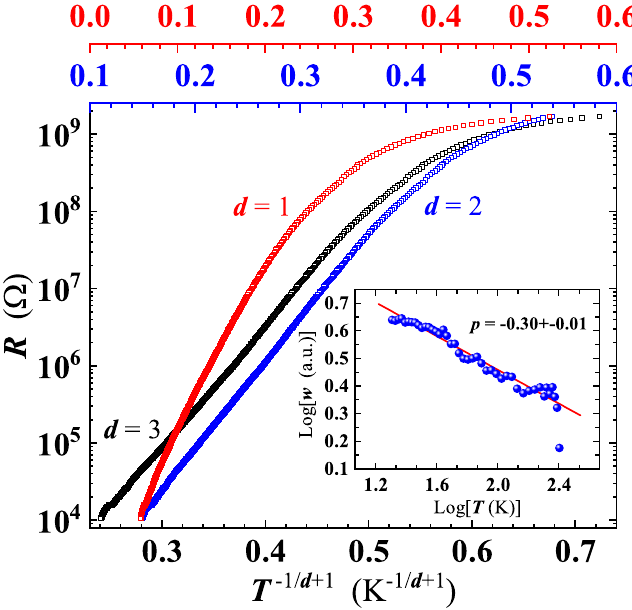
Figure 10. Analysis of the variable range hopping conduction mechanism in the GS, plotting the sample resistance as a function of: T − 1/4 (black squares, bottom axis); T − 1/3 (blue squares, intermediate-top axis) and T − 1/2 (red squares, top axis). Inset: reduced activation energy as a function of T , on a Log-Log scale. Plotted points are derived by applying the method described in the text to get the correct value of d in Equation (4). Red line is the linear least-squares fit of the plotted data, yielding the effective dimensionality d = 2.3 ±